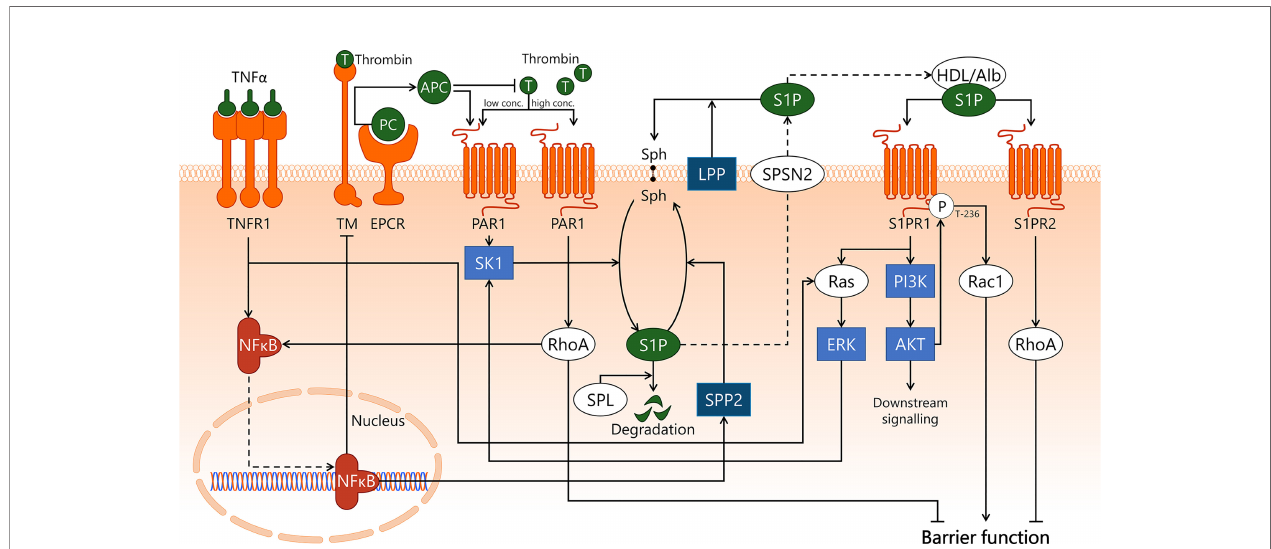
FIGURE 4 | APC/S1P and associated signal transduction pathways in endothelial cells during sepsis. Sepsis pathophysiology is closely associated with microvascular leakage and aberrant coagulation. APC is involved in both processes, by promoting endothelial barrier function and by exerting anti-coagulatory effects. The conversion of protein C to APC by EPCR is stimulated upon association with thrombin/TM, after which APC inhibits thrombin formation. In sepsis- associated in fl ammation, pro-in fl ammatory cytokines such as TNF a are recognised by TNFR1 on the endothelial cell surface, leading to activation of Ras/ERK, and activation and subsequent translocation to the nucleus of transcription factor NF- k B. NF- k B induces downregulation of TM, hereby decreasing the turnover of PC to APC. APC and low concentrations of thrombin activate PAR1, which activates SK1. SK1 phosphorylates the lipid sphingosine to form S1P. This process can be reversed by SPP2, whose activity is increased upon NF- k B-induced transcription, and S1P can also be irreversibly degraded by SPL. S1P is transported out of the cell by SPNS2, where it is able to associate with carrier proteins such as albumin and HDL, or can be dephosphorylated by LPP. S1P can then activate S1PR1, leading to activation of Ras/ERK, which stimulates SK1 activity. S1PR1 activation also stimulates PI3K/AKT activity, which enables AKT to phosphorylate S1PR1 at the T-236 site, which is required for its ability to activate Rac1 and promote endothelial barrier function. Alternatively, a disruptive effect on the endothelial barrier function by RhoA is established both by activation of S1PR2 by S1P and through high concentrations of thrombin activating PAR1. In addition, speci fi cally thrombin/ PAR1-activated RhoA promotes NF- k B transcriptional activities. AKT, protein kinase B; Alb, albumin; APC, activated protein C; EPCR, endothelial protein C receptor; ERK, extracellular signal-regulated kinase; HDL, high-density lipoprotein; LPP, lipid phosphate phosphatase; NF- k B, nuclear factor kappa-light-chain-enhancer of activated B cells; PAR1, protease-activated receptor 1; PC, protein C; PI3K, phosphoinositide 3-kinase; Rac1, Ras-related C3 botulinum toxin substrate 1; Ras, Ras protein subfamily; RhoA, Ras homolog gene family, member A; S1P, sphingosine-1-phosphate; S1PR1, sphingosine-1-phosphate receptor 1; S1PR2, sphingosine- 1-phosphate receptor 2; SK1, sphingosine kinase 1; Sph, sphingosine; SPL, sphingosine-1-phosphate lyase; SPNS2, Spinster homolog 2; SPP2, sphingosine-1- phosphate phosphatase 2; T, thrombin; TM, thrombomodulin; TNFR1, tumor necrosis factor alpha receptor 1; TNF a , tumor necrosis factor